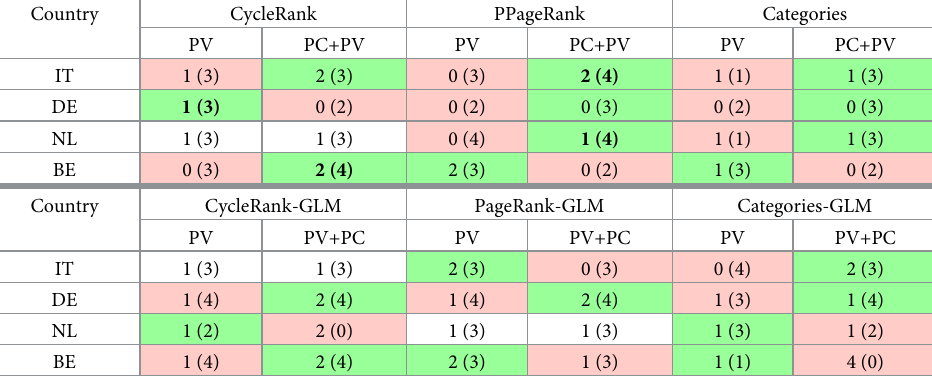
Table 6. Number of influenza peaks predicted correctly (# peaks = 4). The bold values indicate the best results over all combinations of models and datasets. The first value in each cell indicates how many peaks the models predicted correctly. The second value indicates how many peaks were predicted in the ± 2 weeks range. The green colour indi- cates the best results by either using the PV or the PC+PV dataset, by keeping both the country and the model fixed (no colour means no